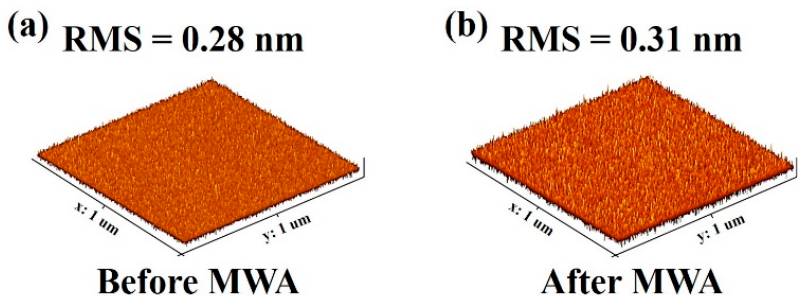
Figure 8. AFM images of the thin film under 0.8 Torr chamber pressure ( a ) before microwave annealing and ( b ) after microwave annealing. A microwave annealing power of 440 W, an annealing temperature of 180 ◦ C, and an MWA time of 20 min were used in all cases.